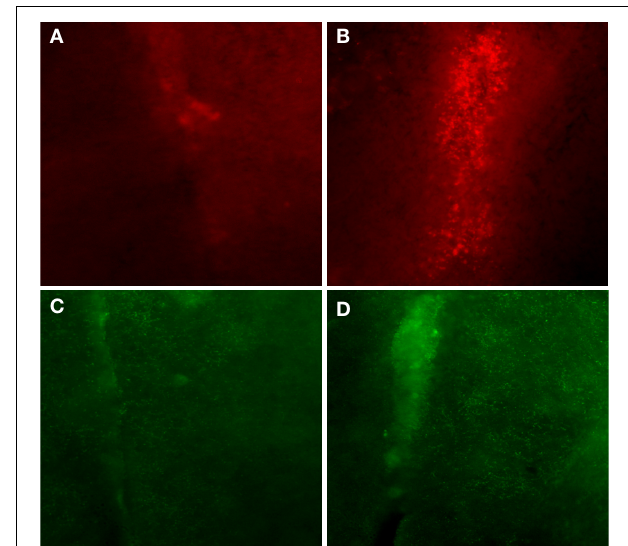
FIGURE 9 | Immunohistochemistry of thoracic (T 10 ) spinal cord (two segments below the injury epicenter), especially areas adjacent to dorsal median septum showed huge upregulation of BDNF (B) following 1week of bicycle locomotor training compared with contused untrained control (A). The GABA synthetic enzyme, glutamic acid decarboxylase (GAD 67 ) showed also greater immunoreactivity (D) in the same area (1week bicycle training) compared with untrained contused control (C ; 20 ×